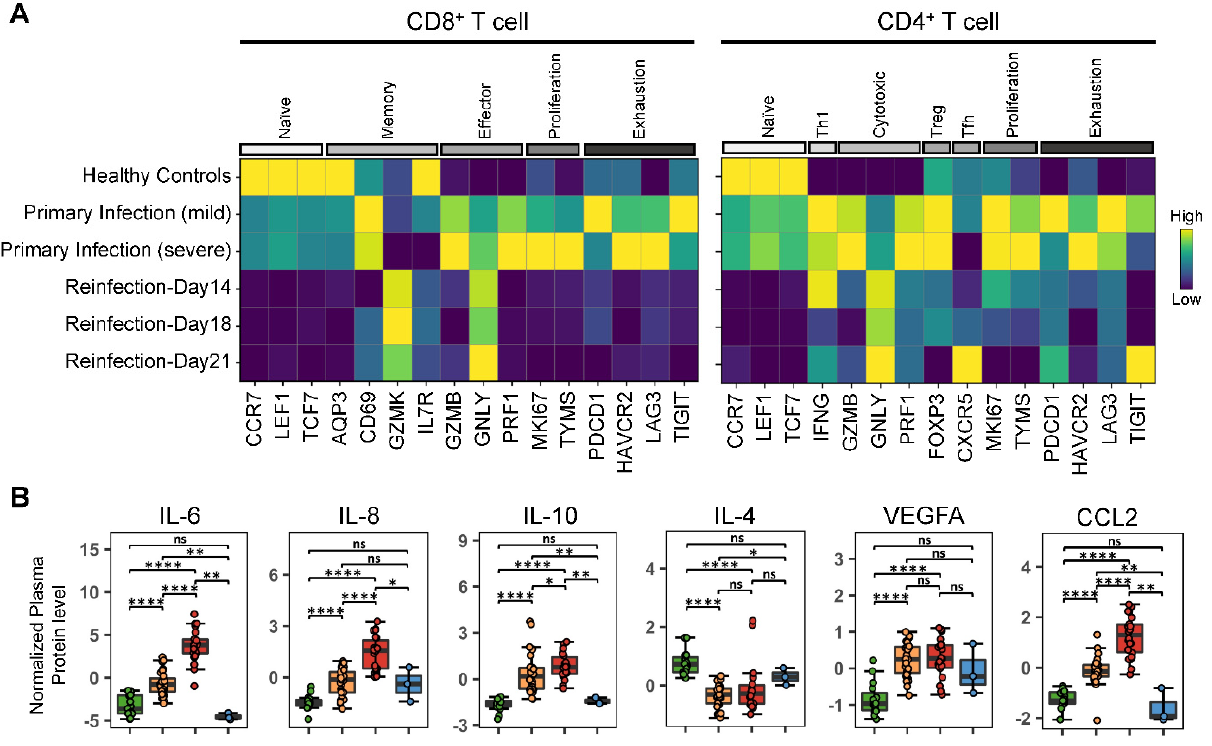
post-onset of symptoms (highlighted by pink bar). Serostatus and days post symptoms onset are given on the right y -axis. Columns indicate the class of each IGH sequence with the IGHV gene indicated on the x -axis. The left y -axis indicates CDR-H3 length in amino acids (AA). Dots indicate B cell clonal lineages. Point color indicates median IGHV somatic hypermutation frequency for each clone, and point size indicates the number of reads in the clone. Points are jittered to decrease over-plotting. Panel ( B ): The bar plot summarizes single-B cell transcriptome data indicating the antibody isotype expressed by B cells in the reinfected patient’s blood, plotted as the frequency of usage of each isotype.